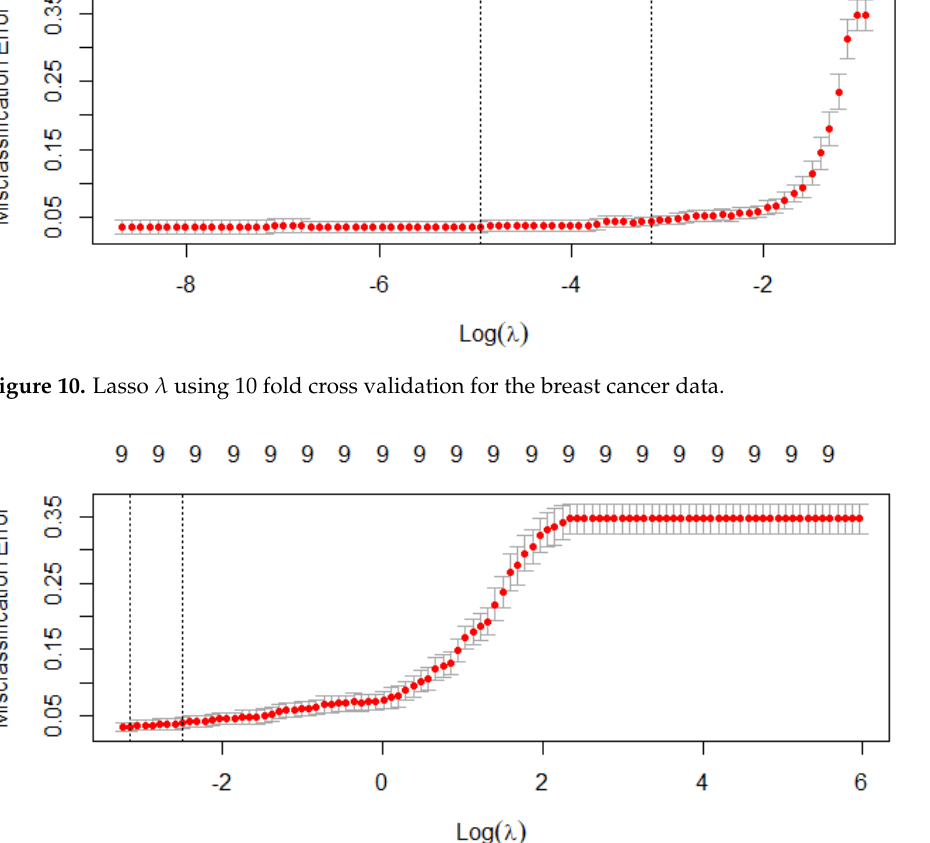
Figure 11. Ridge λ using 10 fold cross-validation for the breast cancer